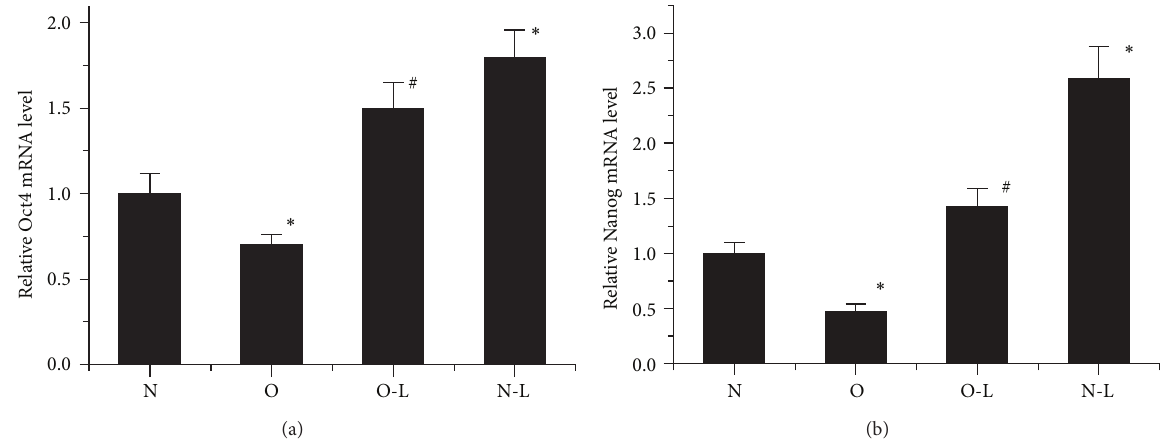
Figure 2: Effect of low oxygen on expression of stemness genes in MSCs. (a) Expression of Oct4 in MSCs 5 days after normoxia or low oxygen culture. (b) Expression of Nanog in MSCs of each group. The data were drawn from three independent experiments and the results were expressed as mean ± SD. ∗ 𝑃 < 0.05 versus N Group. # 𝑃 < 0.05 versus O Group.